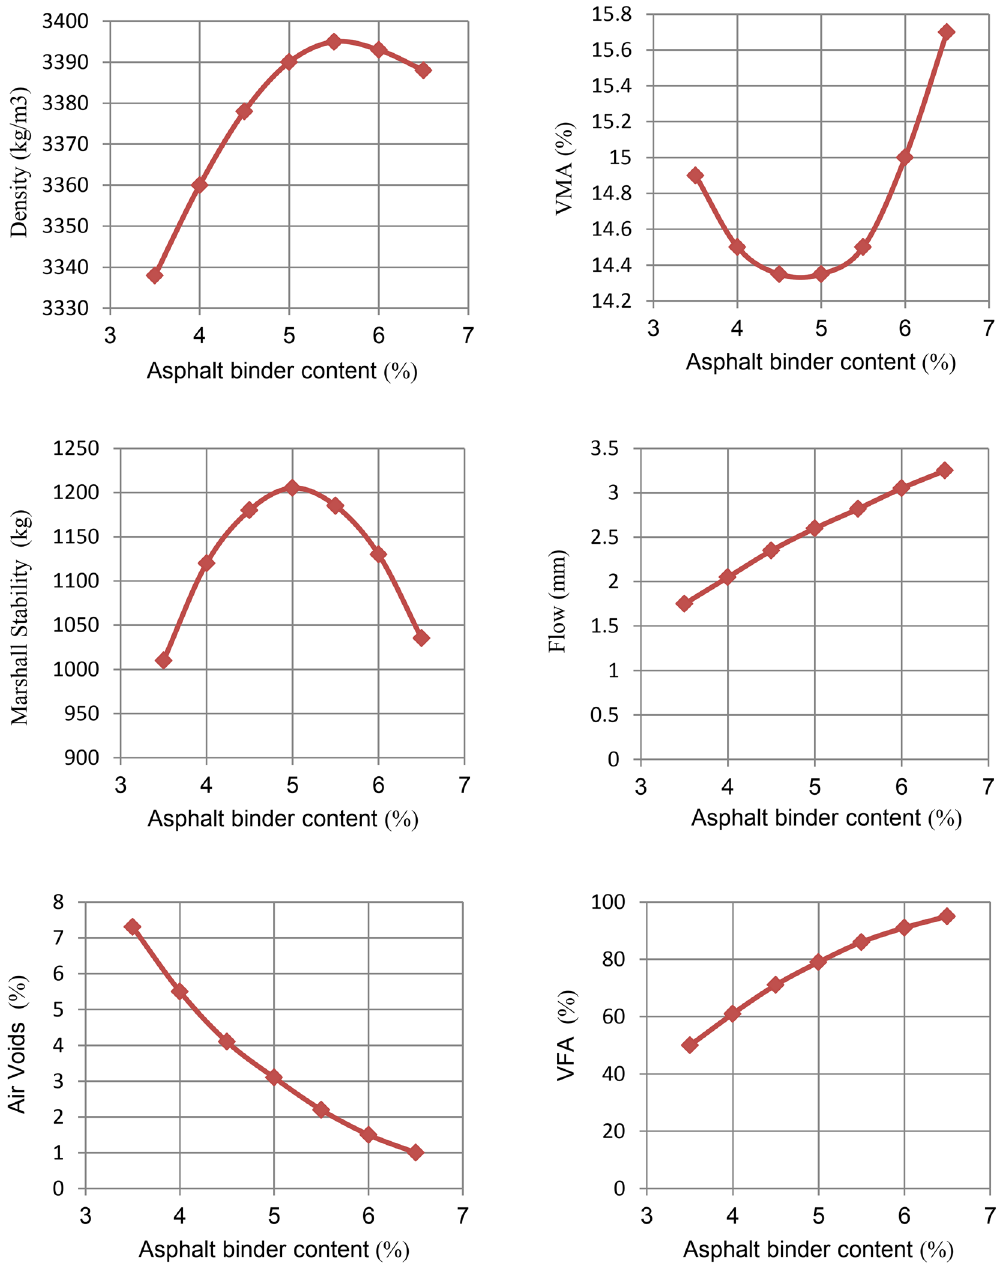
Fig. 5 Determine the asphalt binder content based the Marshall Mix design